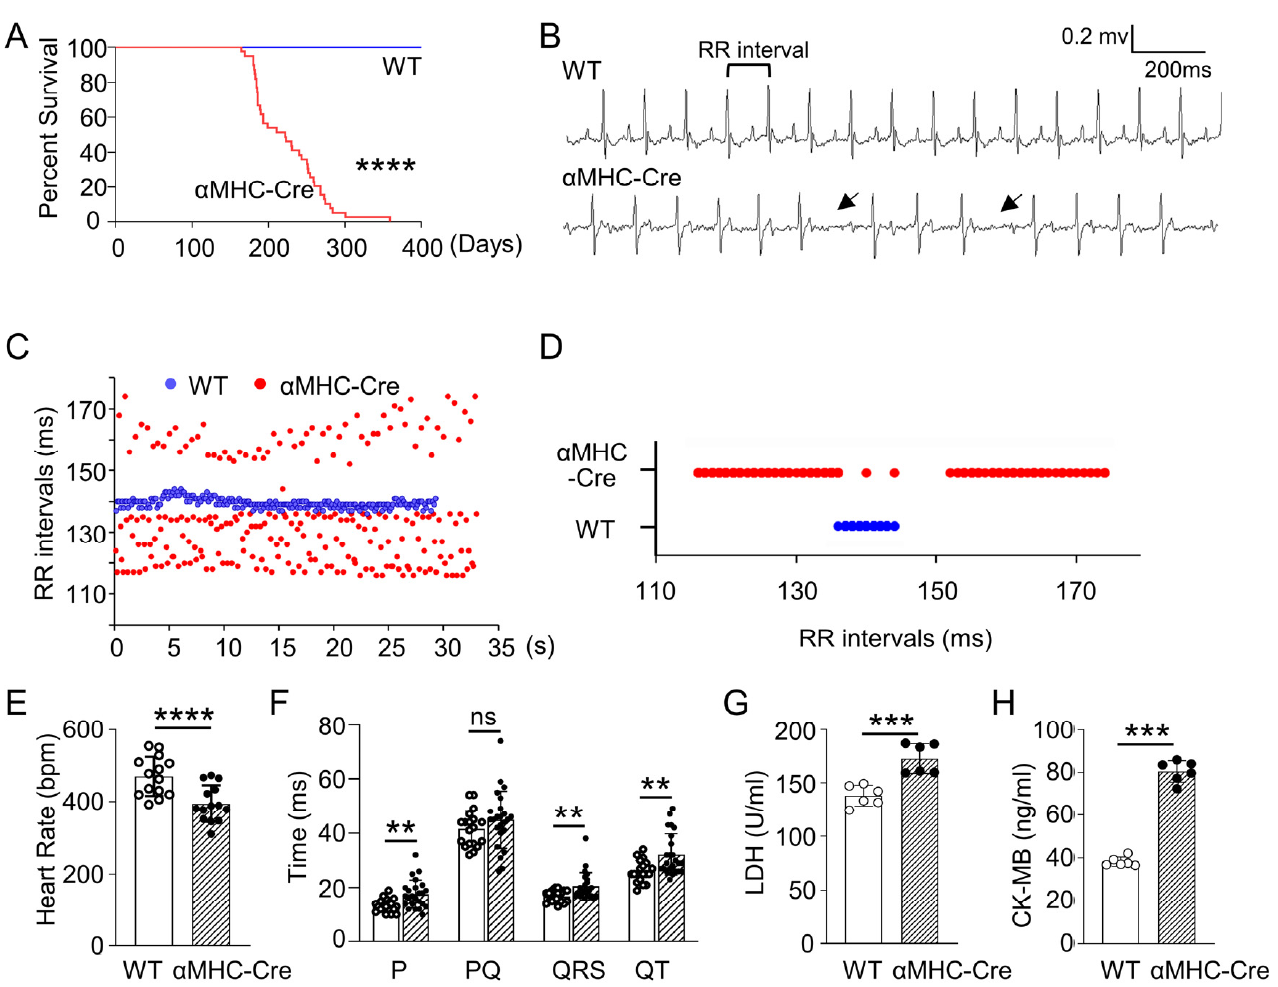
Figure 1. α MHC-Cre mice displayed progressive death accompanied with arrhythmia and cardiomyopathy at six months of age. ( A ) Kaplan–Meier survival curve analysis of α MHC-Cre compared to WT mice. α MHC-Cre mice began dying at 6 months, dropping off intermittently until 12